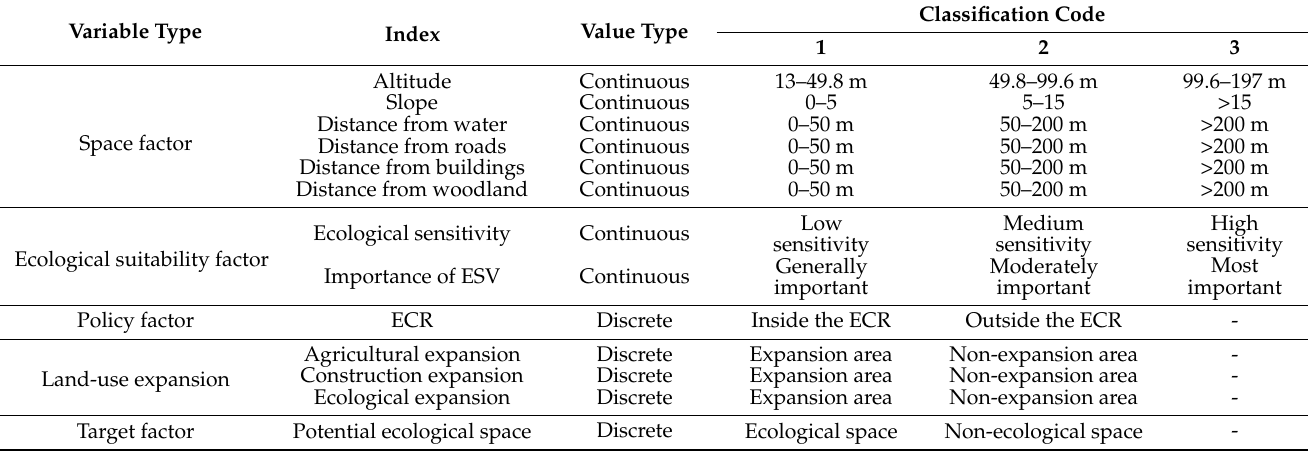
Table 2. Discrete classification table of